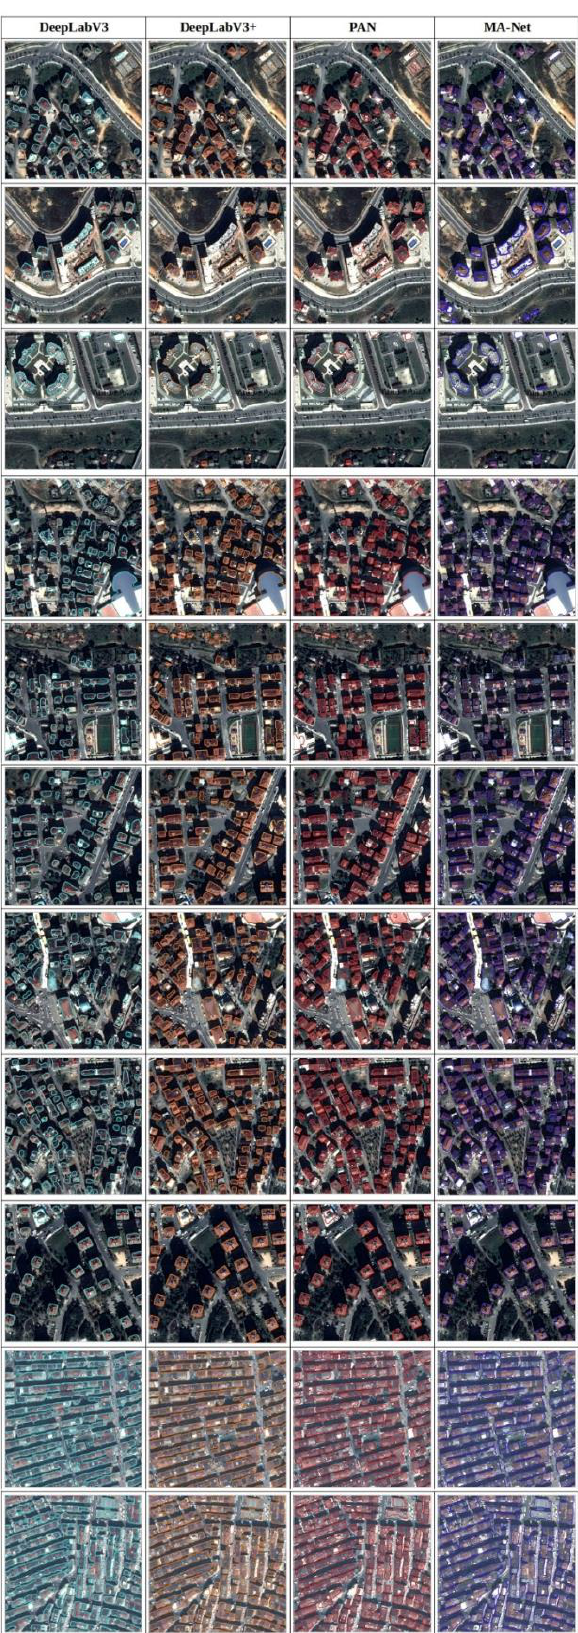
Figure 8 . Comparison of DeepLabV3, DeepLabV3+, PAN and MA-Net architectures prediction on the test